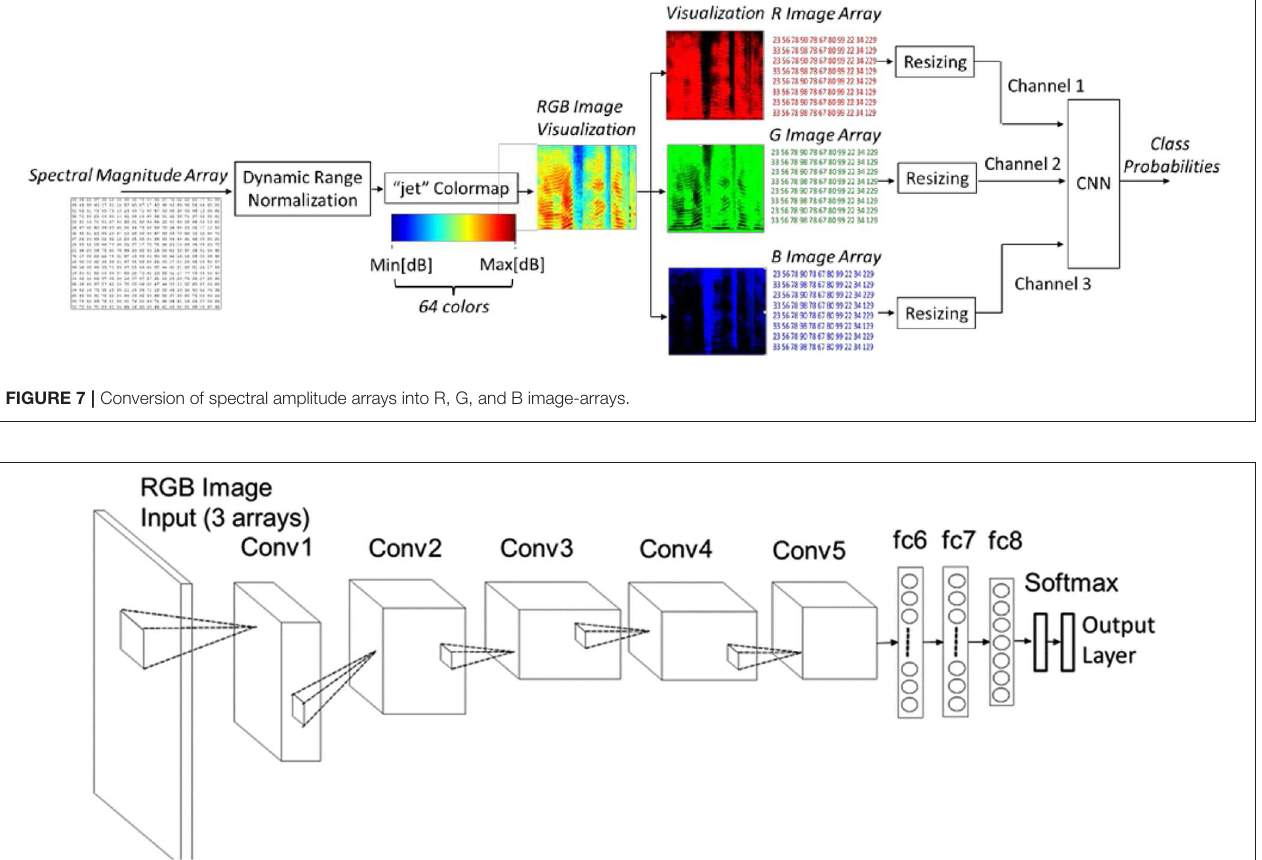
FIGURE 8 | Structure of AlexNet.